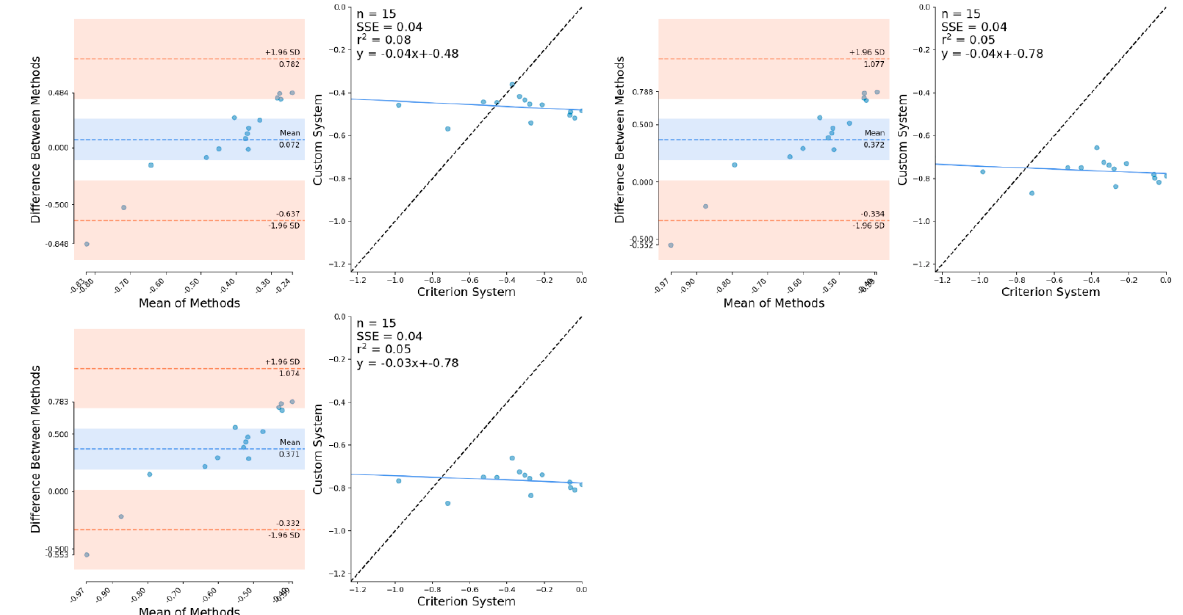
Figure A7. Bland-Altman and linear regression plots demonstrating the differences between OpenPose unfiltered (top- left), low-pass filtered (top-right) and Kalman smoothed (lower-left) CoM horizontal position against marker-based CoM horizontal position during pushing.